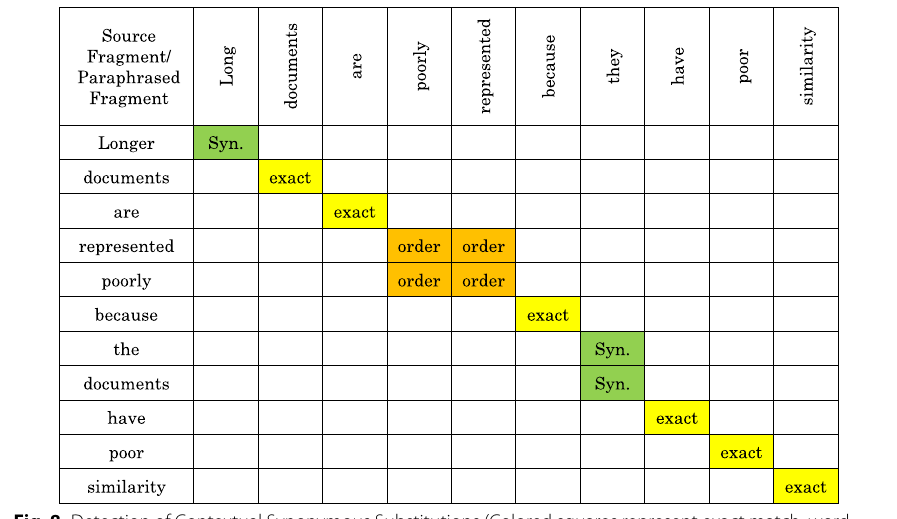
Fig. 8 Detection of Contextual Synonymous Substitutions (Colored squares represent exact match, word reordering and synonymous